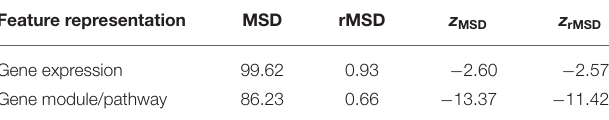
TABLE 1 | Quantitative performance of hierarchical